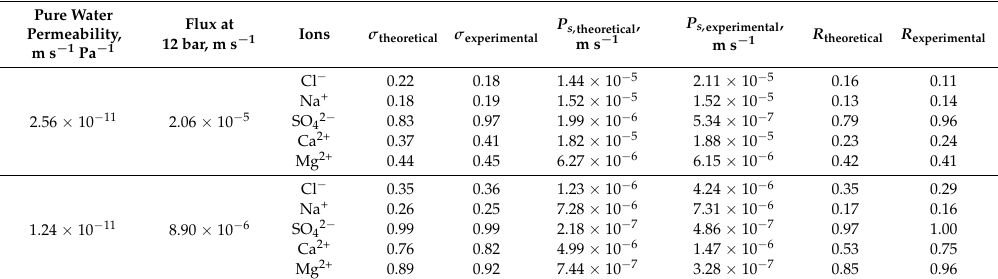
Table 5. Comparison of experimental and theoretical values from the Spiegler–Kedem equation. Pure Water